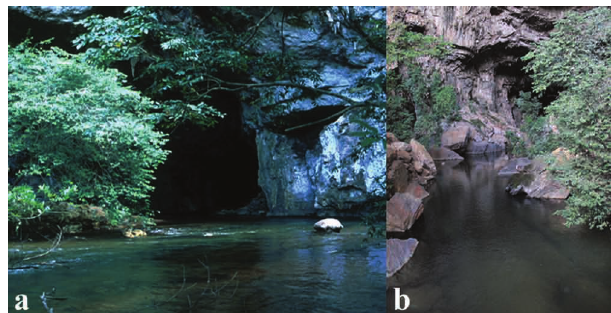
Fig. 2. ( a ) Sinkhole of the São Vicente cave system (entrance of the São Vicente I cave), type-locality of Eigenmannia vicentespelaea . Photography: A. Gambarini; ( b ) rio da Lapa showing the place of E. trilineata occurrence, a typical slow to moderate water current habitat. Photography: M. E. Bichuette.